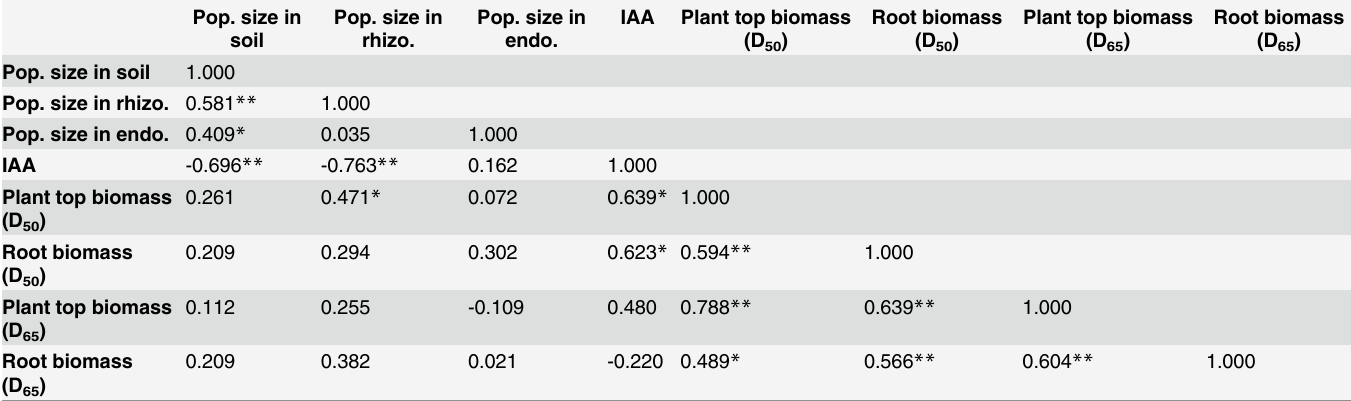
Table 7. Pearson ’ s correlation coefficients for the plant and bacterial parameters at D 50 (before anthesis) and D 65 (ear harvest). Pop. size in